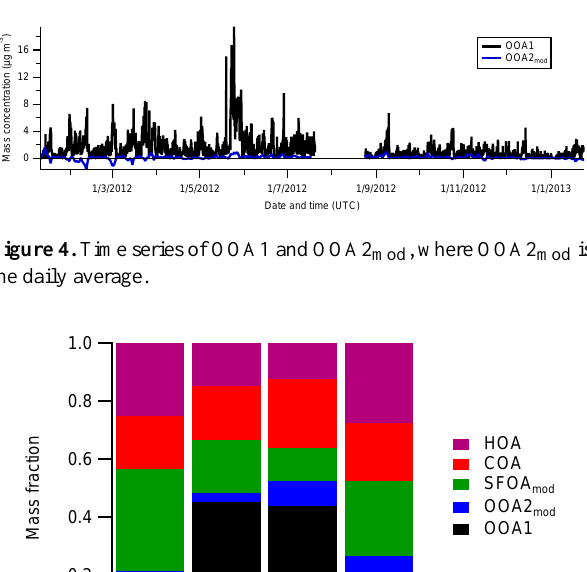
Figure 6. (a) OOA1 seasonal median diurnal profiles. (b) Average seasonal concentration of OOA1, with the annual average denoted by the thick horizontal line. (c) Average seasonal concentration of OOA2 mod , with the annual average concentration denoted by the thick horizontal line, both estimated in Sect. 4.4. Note that these data do not include the summer period (see Sect.